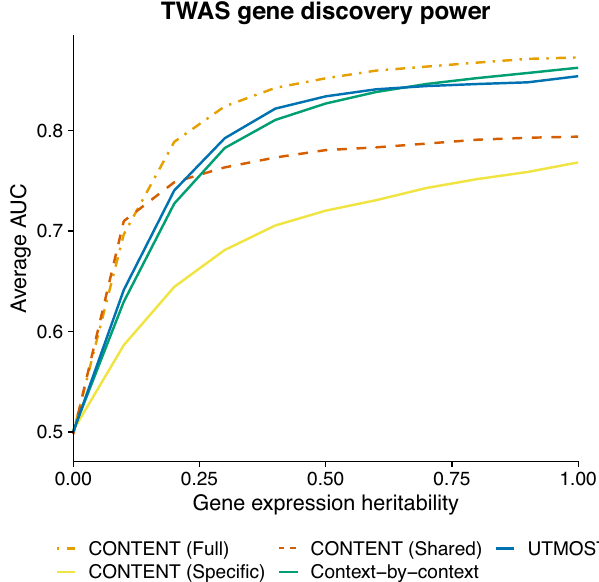
Fig. 5 | CONTENT(Full) is powerful, sensitive, and speci fi c in simulated TWAS data. Average AUC from 1000 TWAS simulations while varying the overall herit- ability of gene expression. Each phenotype (1000 per proportion of heritability) wasgeneratedfrom 300(100genes and 3 contexts each) randomlyselectedgene- context pairs' genetically regulated gene expression, and the 300 gene-context pairs' genetically regulated expression accounted for 20% of the variability in the phenotype. In genes with low heritability, CONTENT(Shared) performed similarly to CONTENT (Full), however CONTENT(Full) was the most powerful method in discovering the correct genes for TWAS across the range of heritability. CON- TENT(Full) was signi fi cantly more powerful than UTMOST and the context-by- context approach at all levels of